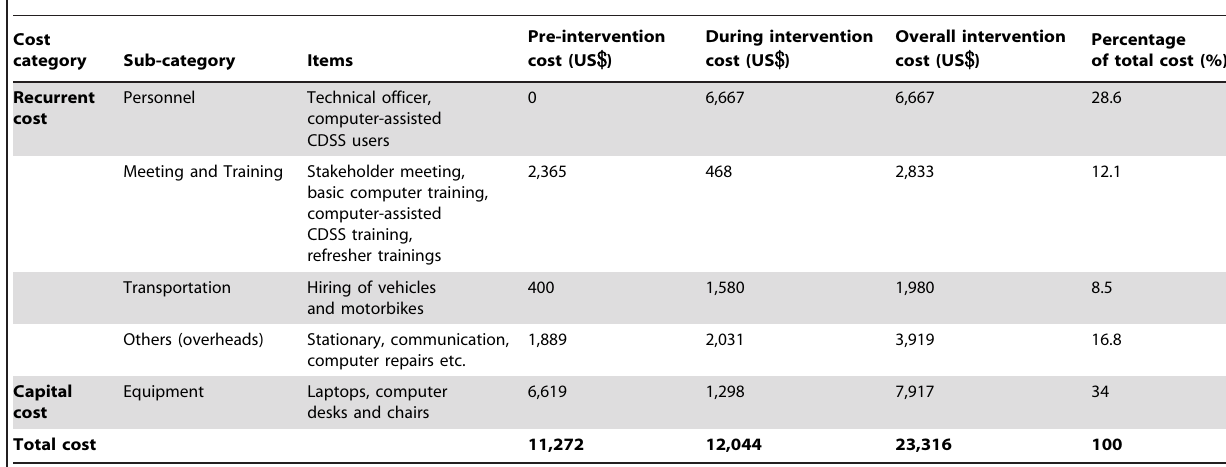
Table 3. Financial costs distribution of computer-assisted CDSS implementation (US $ ).